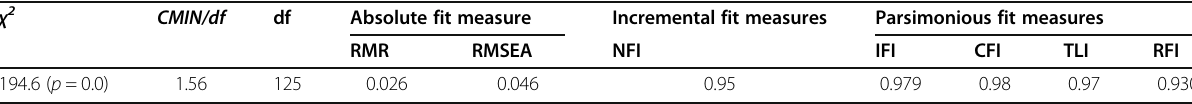
Table 4 Goodness-of-fit